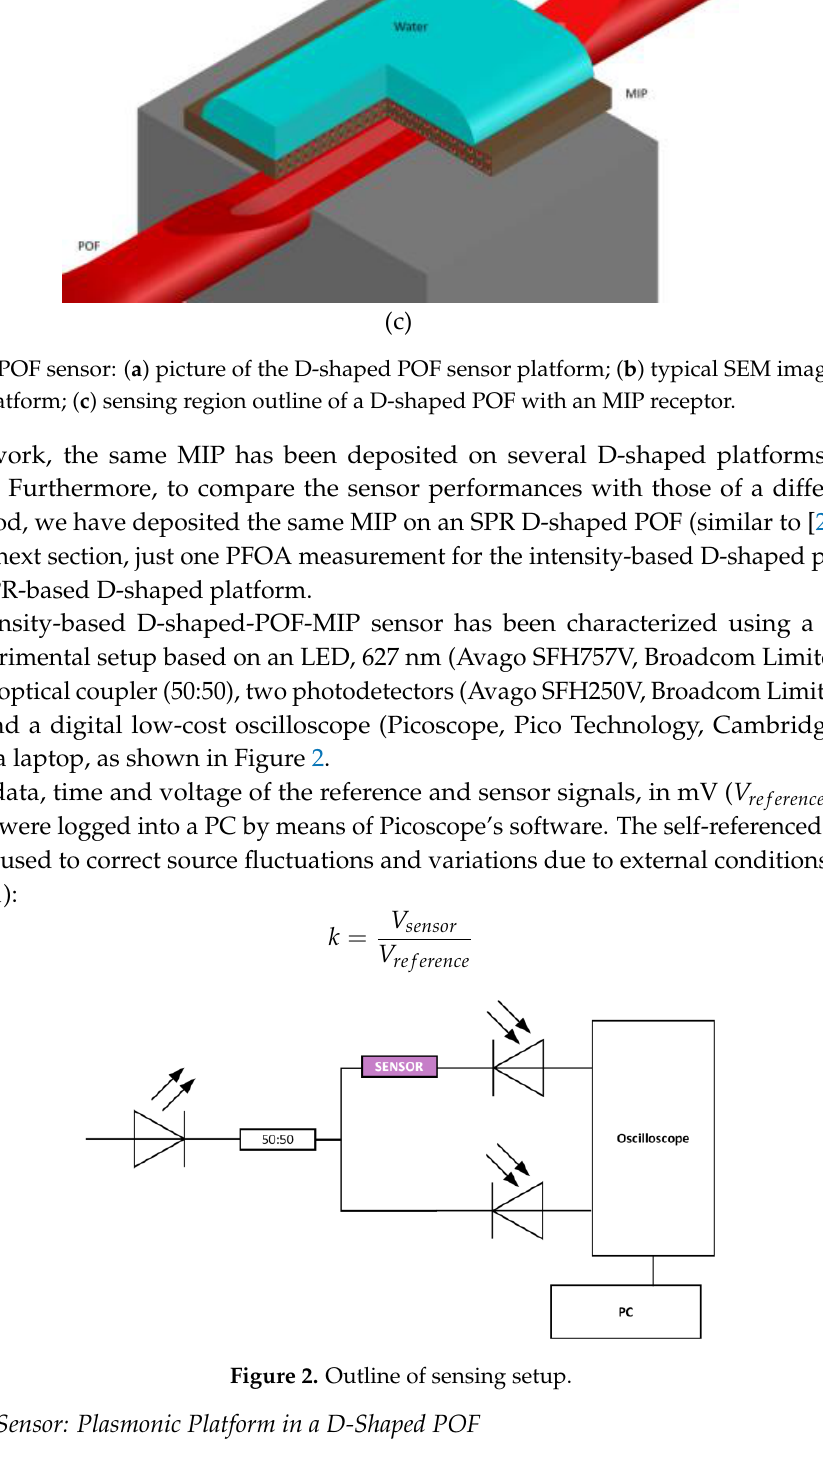
Figure 2. Outline of sensing setup.